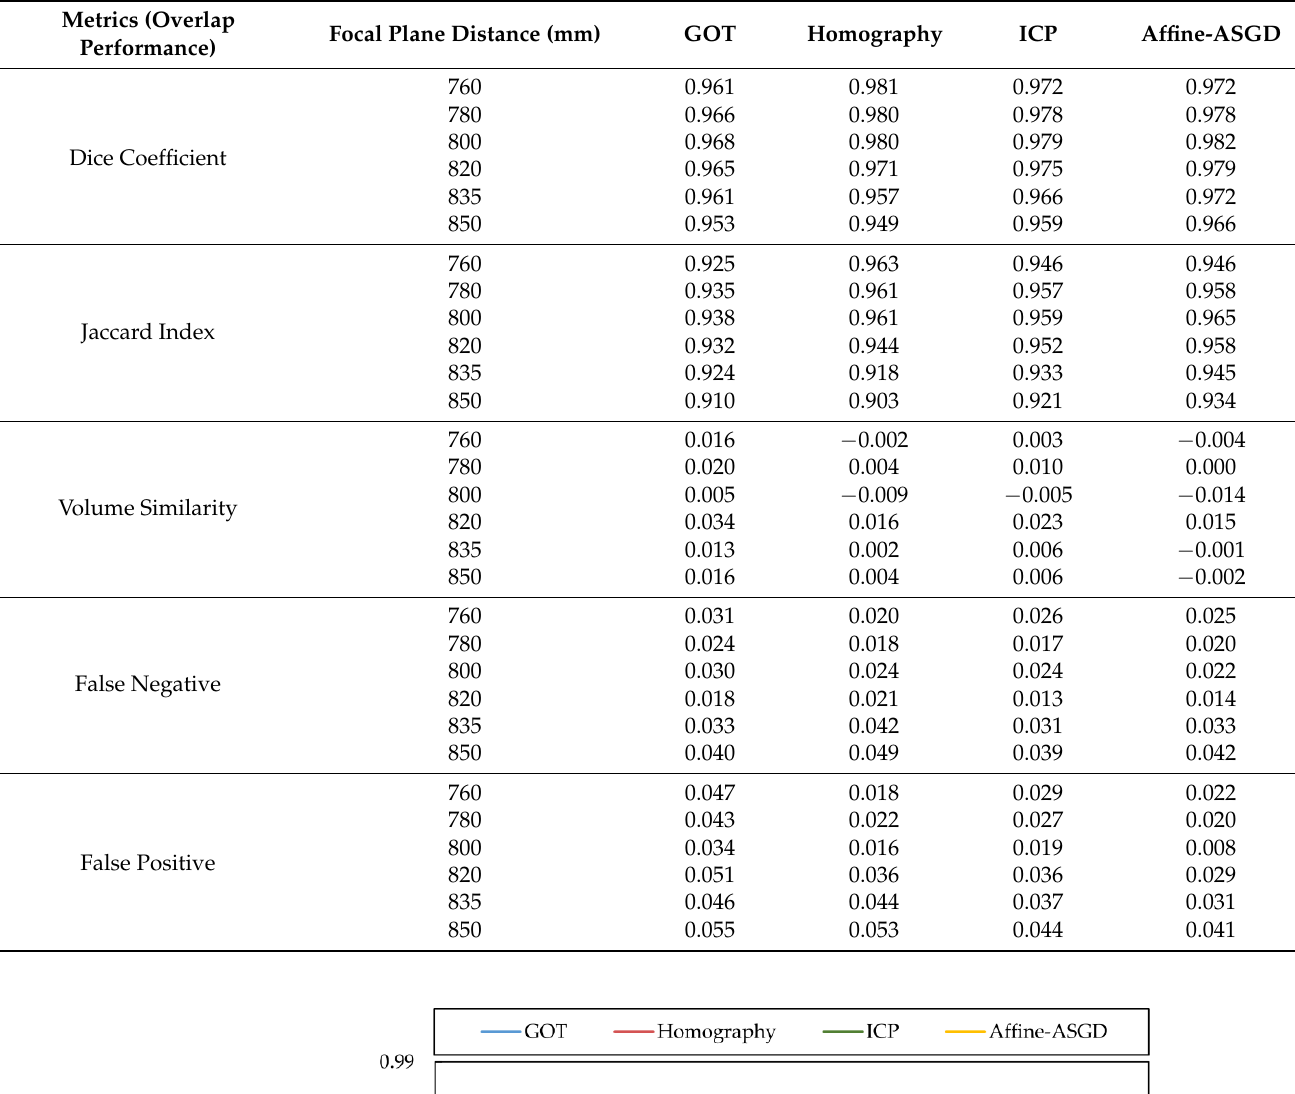
Table 1. Overlap performance with varying subject’s feet distance for different registration methods.